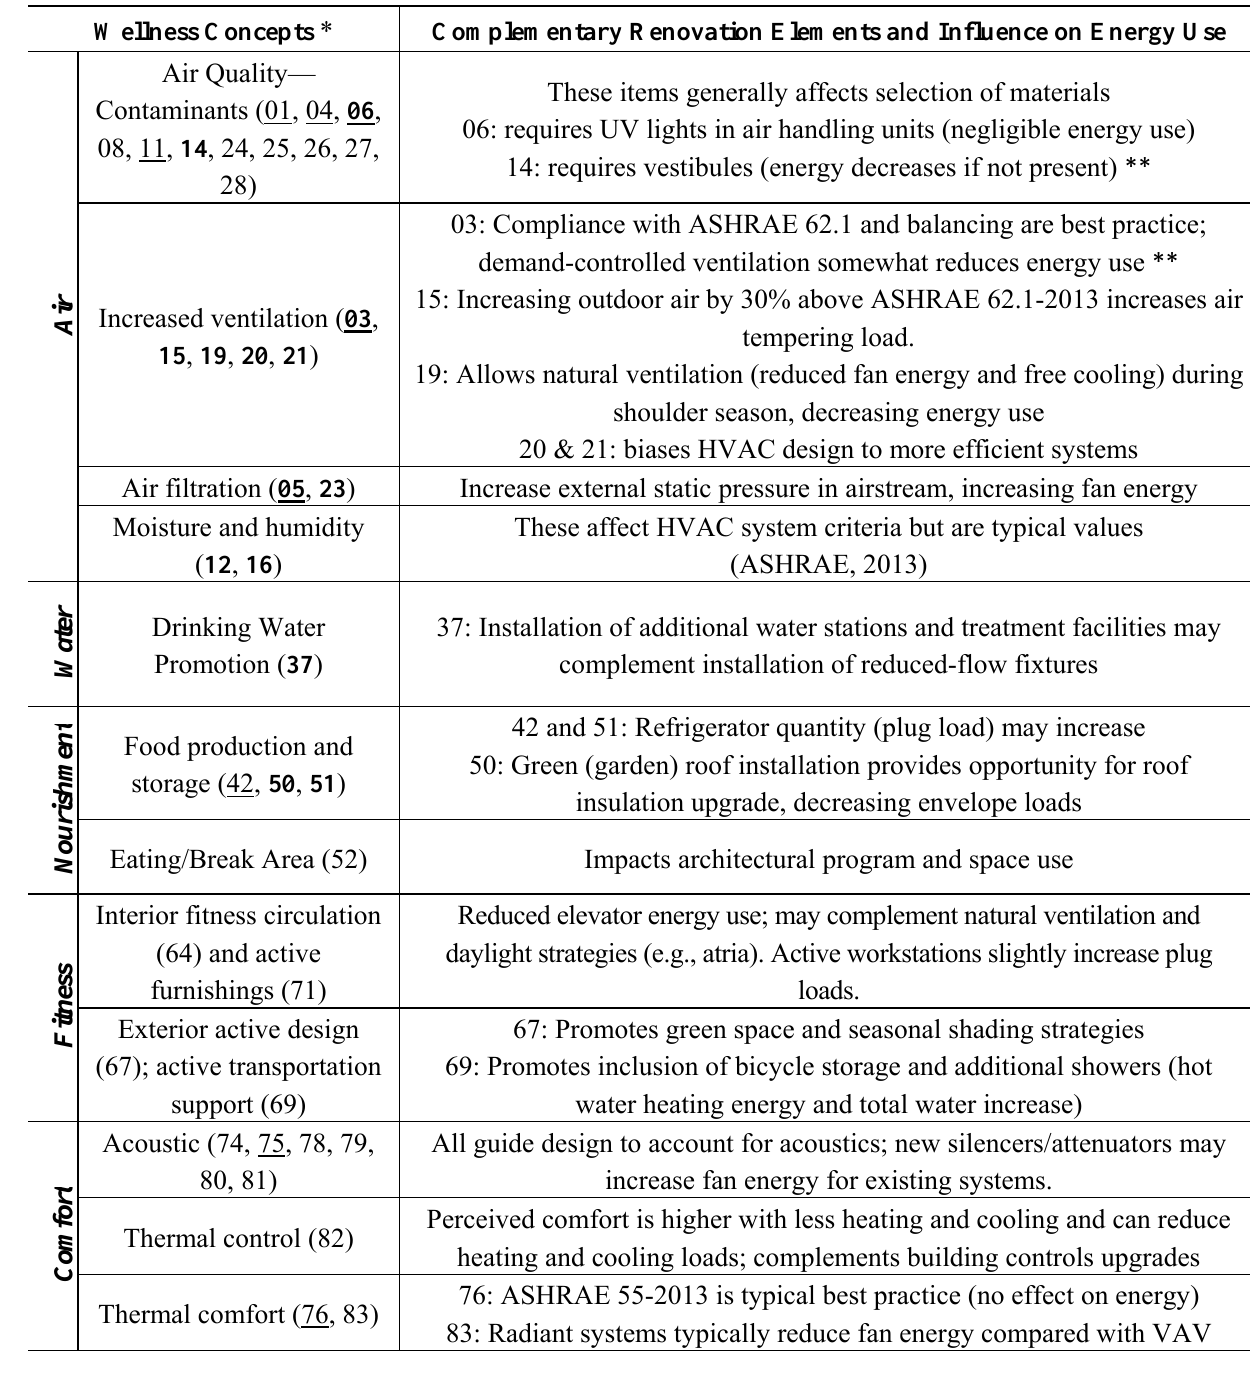
Table 3. WELL ® Building Standard elements affected primarily by construction decisions, complementary energy conservation measures (ECMs) and effect on energy